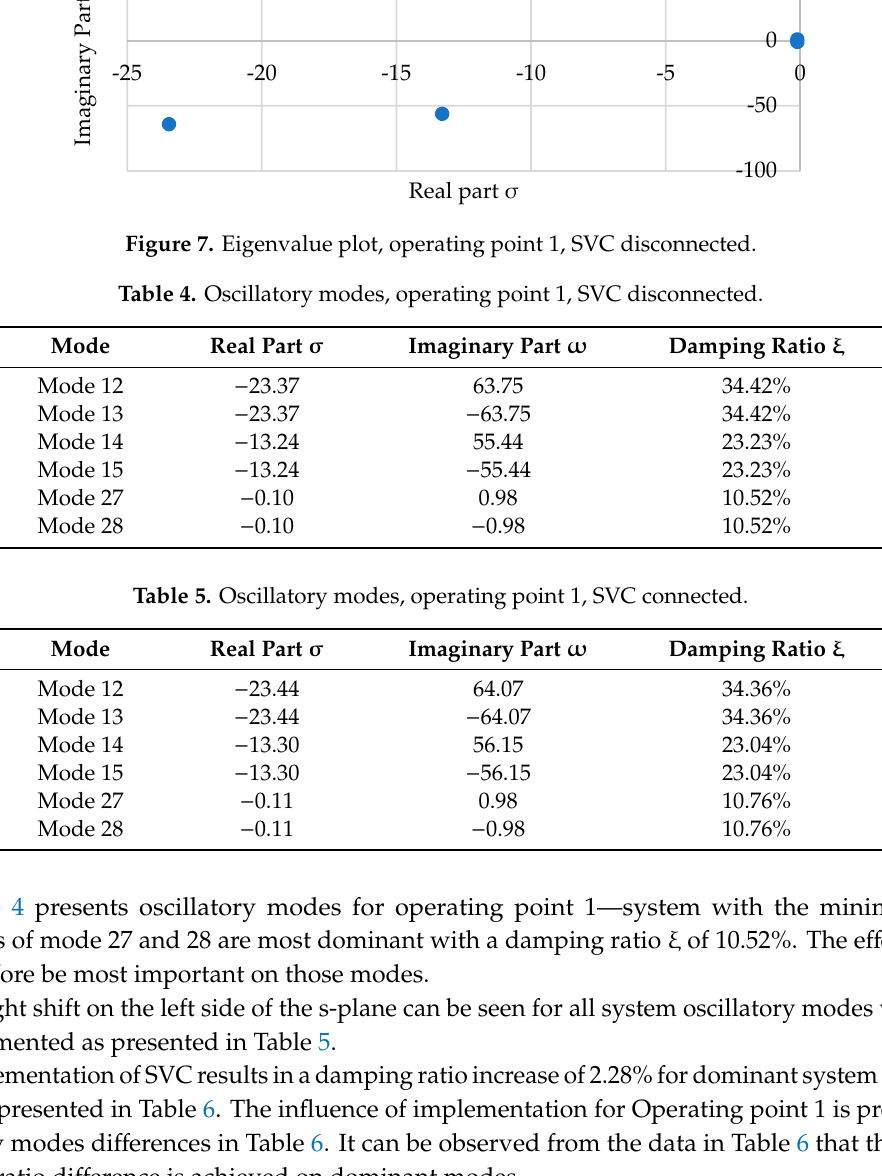
Table 6. Oscillatory modes, operating point 1, difference SVC connected/disconnected.